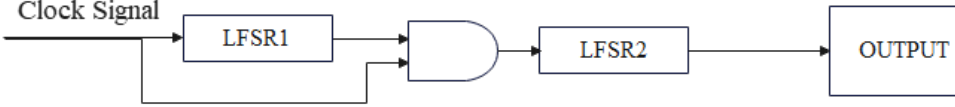
Figure 3. Clock-control generator, which use two LFSRs and one logic